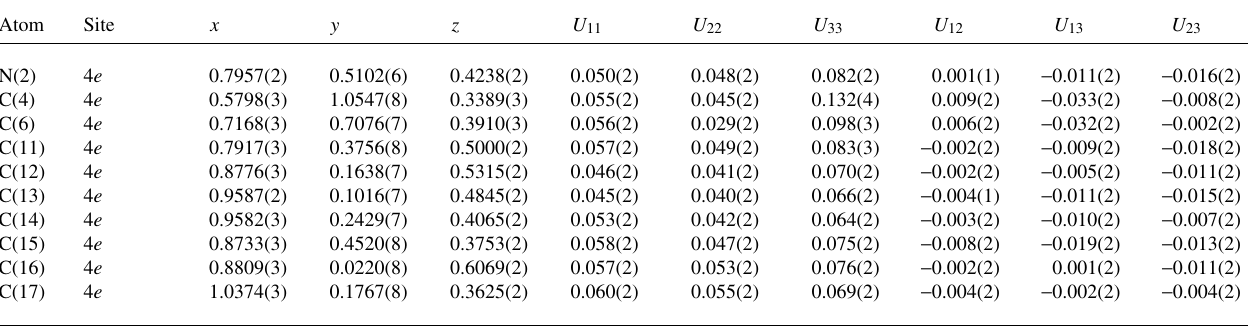
Table 3. Atomic coordinates and displacement parameters (in Å 2 ) .